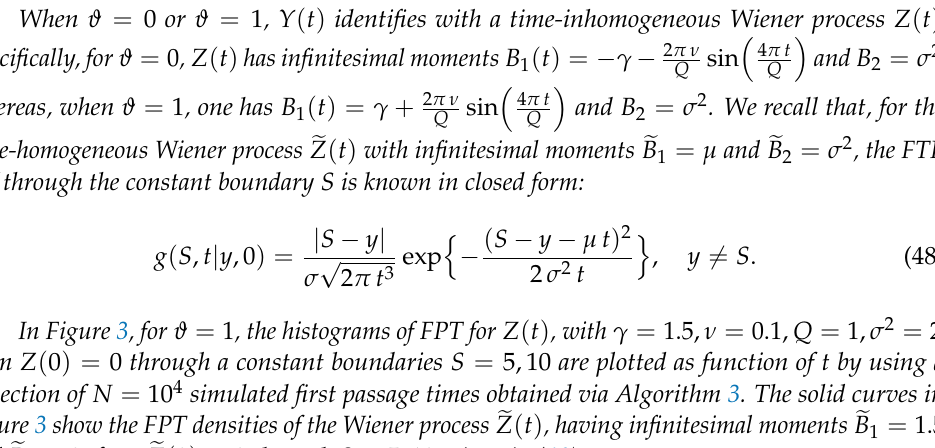
Figure 2. Simulated sample paths of the process Y ( t ) , obtained via (46) with R ( t k − 1 , t k ) given in (47), with β ( t ) = 1.5 + 0.2 π sin ( 4 π t ) and σ 2 ( t ) =